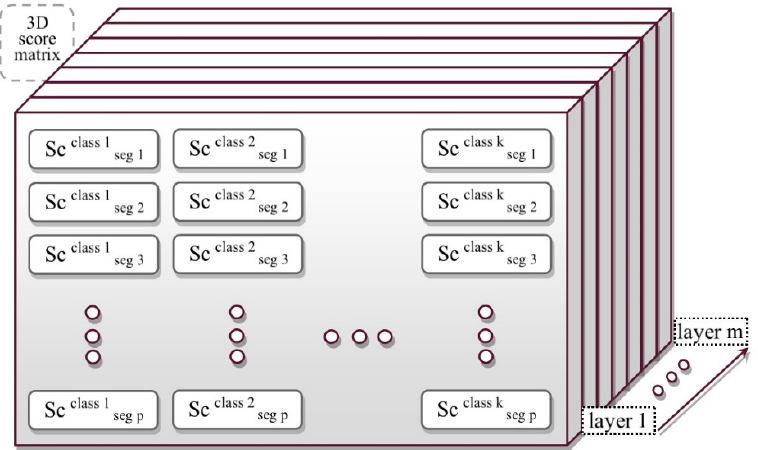
Figure 4. Three-dimensional score (Sc) matrix.